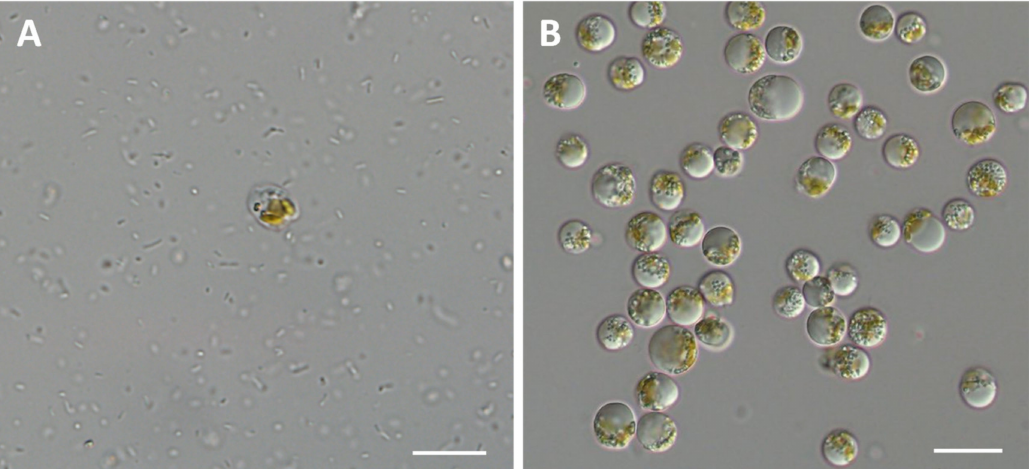
Figure 1. Microscopic observations of non-axenic ( A ) and axenic ( B ) P. malhamensis cultivated with enriched medium. Scale bars = 20 µ m.